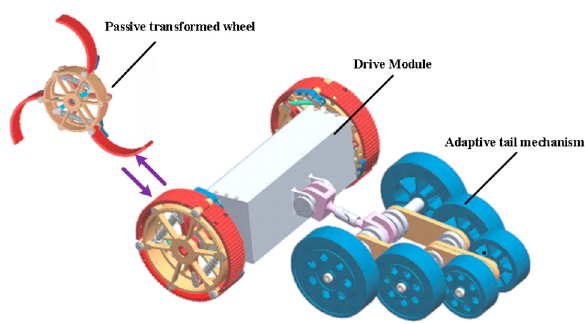
Figure 2. Structure of transformable wheel-legged hybrid robot.